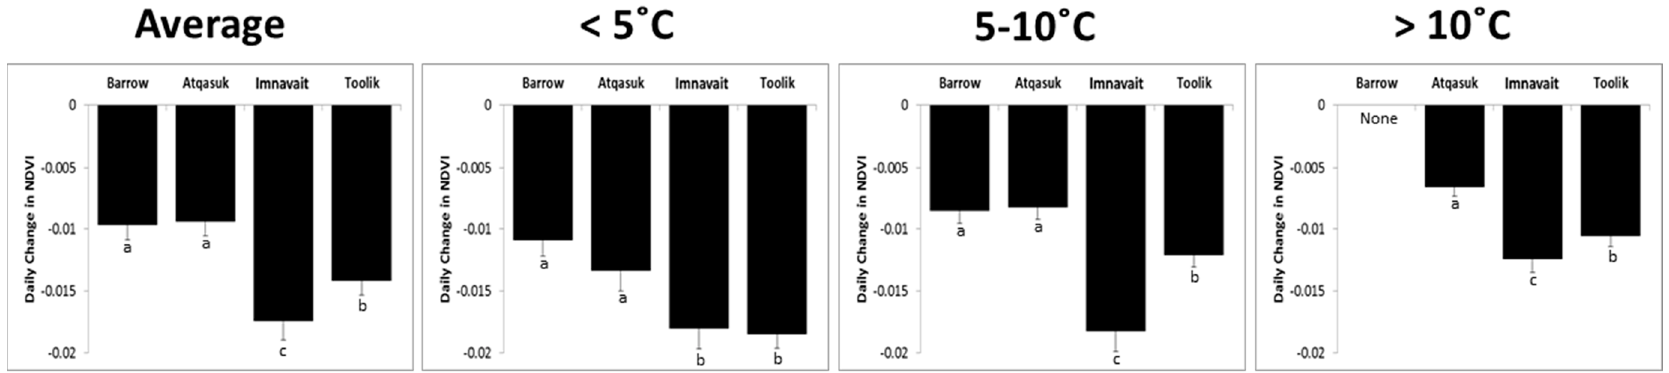
Figure 5. Daily changes in NDVI (as calculated from the three-day lagged NDVI difference) for the four MISP full transects as August averages and following days of temperatures <5 °C, 5–10 °C, and >10 °C. The letters denote statistical differences derived from repeated measures analysis of variance with Tukey’s post hoc analysis.